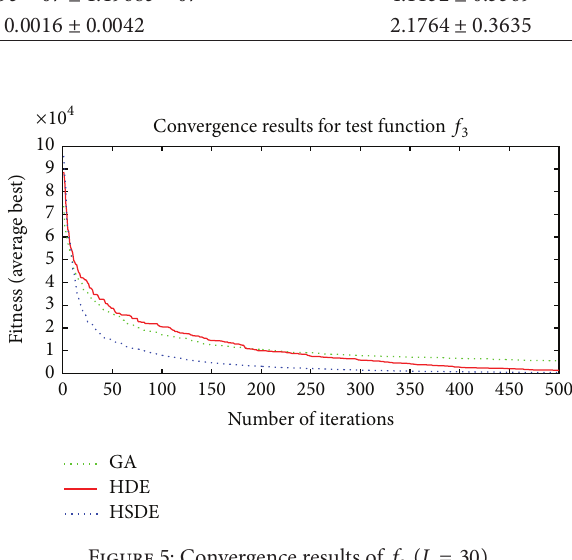
Figure 4: Convergence results of 𝑓 1 ( 𝐿 = 30 ). Figure 5: Convergence results of